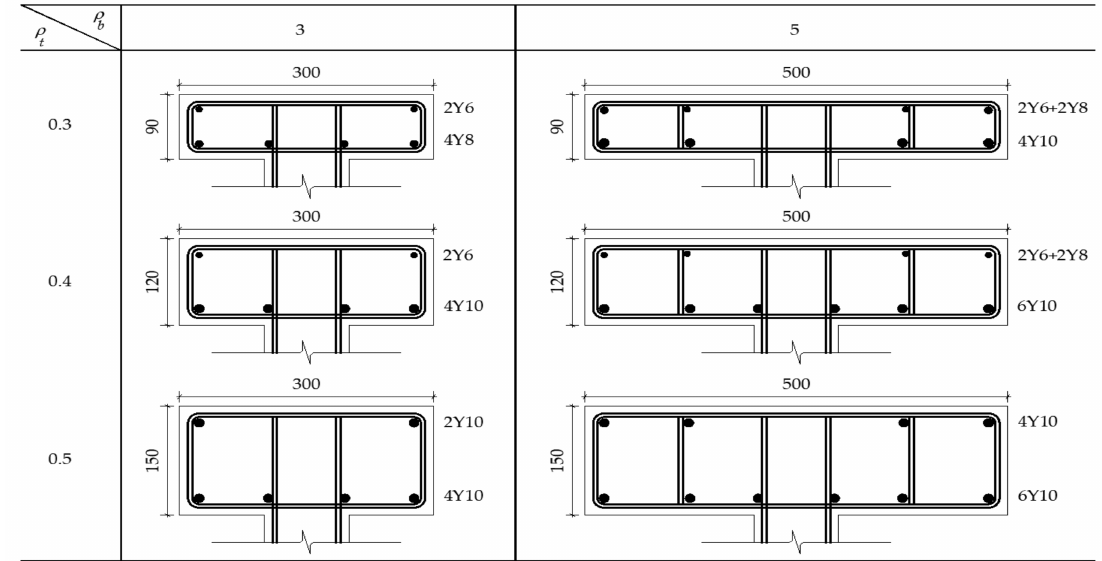
Figure 2. Arrangement of longitudinal reinforcement and” stirrups out of shear zone” in the flange. In Table 1, each specimen is given a code consisting of three parts: the first part refers to reinforcement in the flange (G1 without reinforcement, G2 with longitudinal reinforcement, and G3 with longitudinal and flange stirrups within the two shear zones); the second part refers to the ratio of flange thickness “flange thickness to depth” ( ρ t = 0.3, 0.4, and 0.5); and the third part refers to the flange width “width ratio” ( ρ b = 3 for flange width equal to 300 mm and 5 for flange width equal to 500